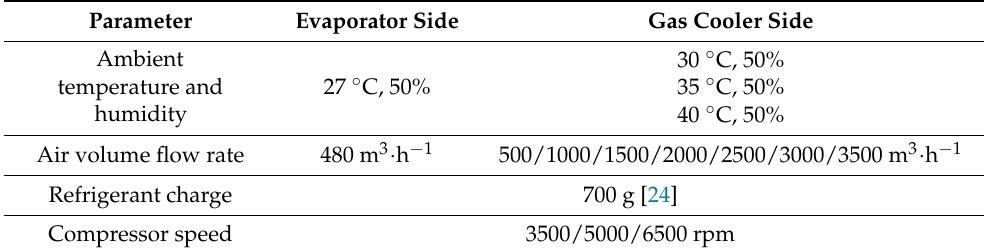
Table 3. Detailed experimental